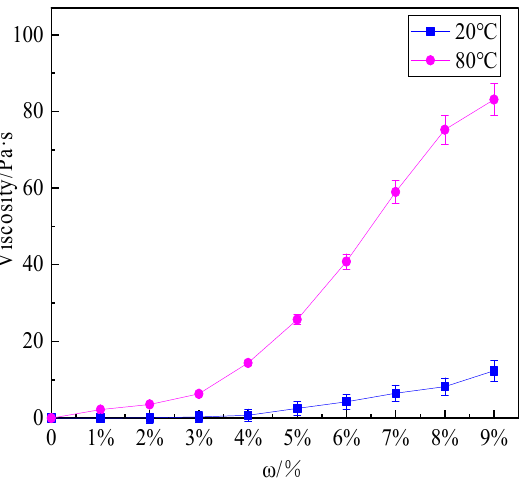
Figure 6. Viscosity of hydrogel solutions with different mass fractions at 20 °C and 80 °C.